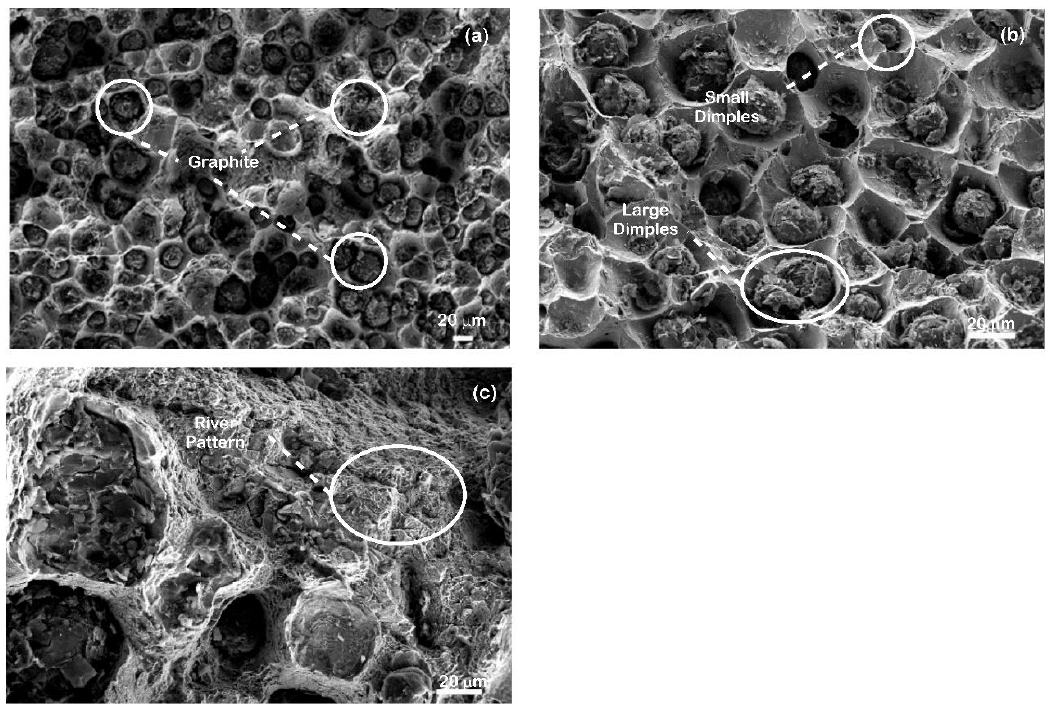
Figure 13. Matrix fracture structure below the various magnification of ( a ) 200 × , ( b ) 500 × , ( c ) 1000 ×.